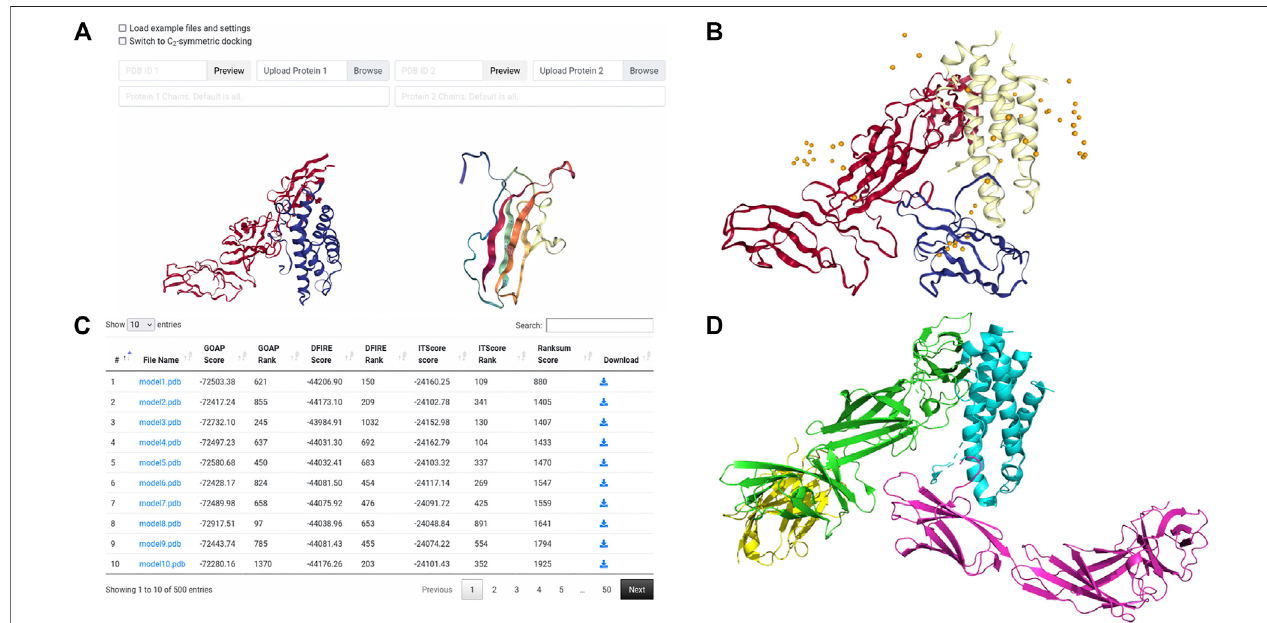
FIGURE 3 | Inputandresultsfor unconstraineddockingofIL23-IL23R. (A) theinputforunconstrainedLZerD.ThemodelofIL23wasuploadedasthereceptoronthe left, whilethemodelofIL23Rwas uploadedasthe ligandonthe right.The chain IDselection fi eldsare blank since wewanttouse allthe chains. Thisdockingrun was done without constraints, so the entire constraints section is empty. (B) the results of unconstrained docking. IL23 is shown in red, while IL23R is shown in blue. The cartoon structureshownisthetop-10model,whichhasan f nat of0.28,anI-RMSDof4.4 Å,andanL-RMSDof7.8 Å,which isofacceptableCAPRIquality.Thedistributionof thetop50ligandcentroidsisindicatedbytheorangespheres. (C) Thetableofmodelscoringinformationforthisdockingrun.Theranksumscore,whichisusedto fi nallyrank themodels,isontheright. (D)